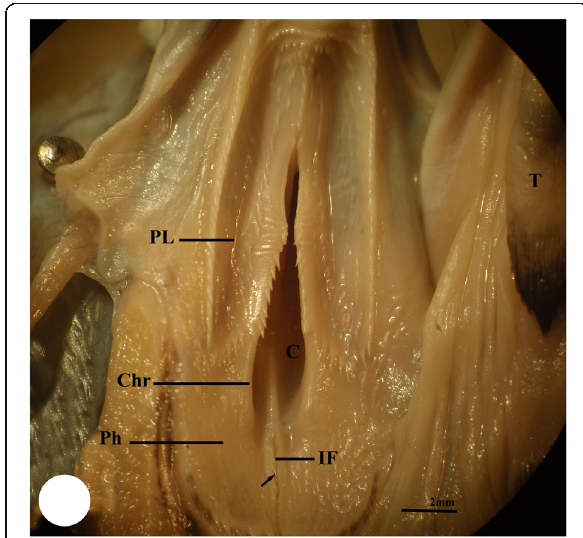
Fig. 2 Photomacrograph of the buccal cavity of common moorhen shows upper jaw (UJ), palate region (PL), choana (C), pharyngeal region (Ph), choana ridges (Chr), and margins of infundibular fissure (arrow) without